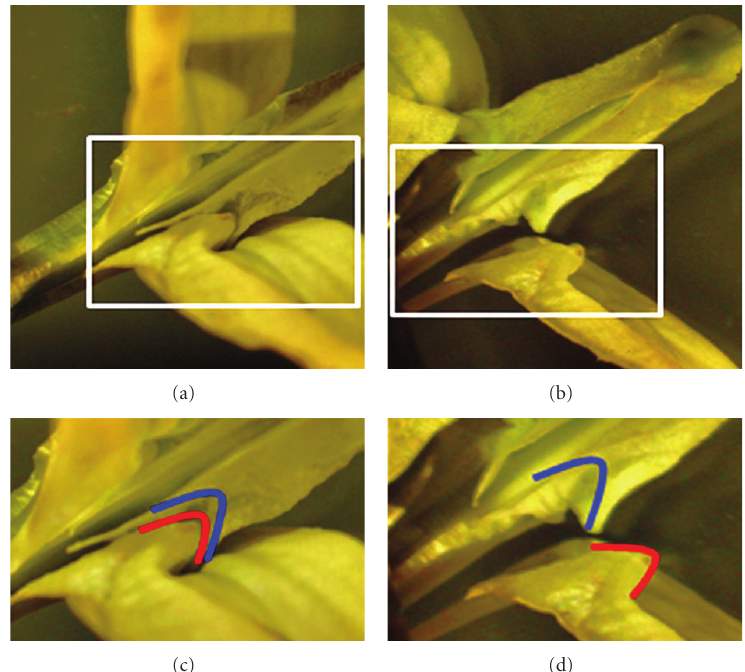
Figure 3: View from above of the wings-keel complex of C. emerus flowers. The notched folds are in the natural position in (a) and (c) while they are detached in (b) and (d).